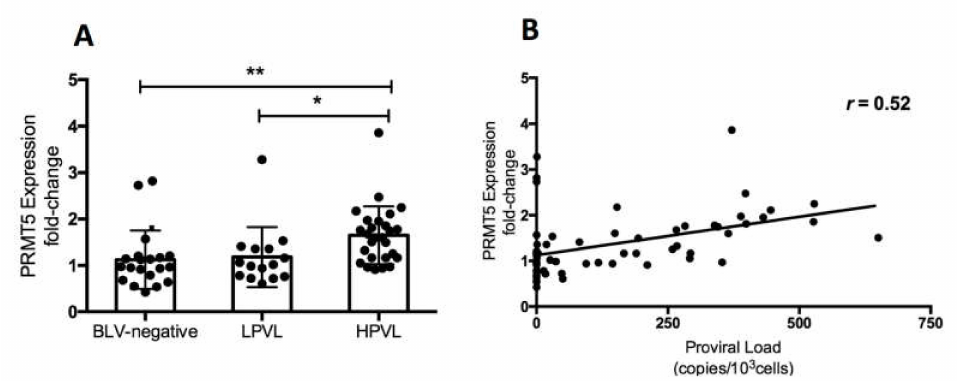
Figure 1. Change in PRMT5 expression at the RNA level in bovine leukemia virus (BLV) infection. ( A )PRMT5expressionattheRNAlevelof20BLV-negativecattle(PVL,proviralload = 0), 15BLV-infected but clinically normal cows with a low PVL (LPVL; PVL ≤ 10,000 copies / 10 5 cells), and 27 BLV-infected but clinically normal cows with a high PVL (HPVL; PVL > 10,000 copies / 10 5 cells) was measured by qRT-PCR and the fold-change was calculated using the ∆∆ CT method with normalization to